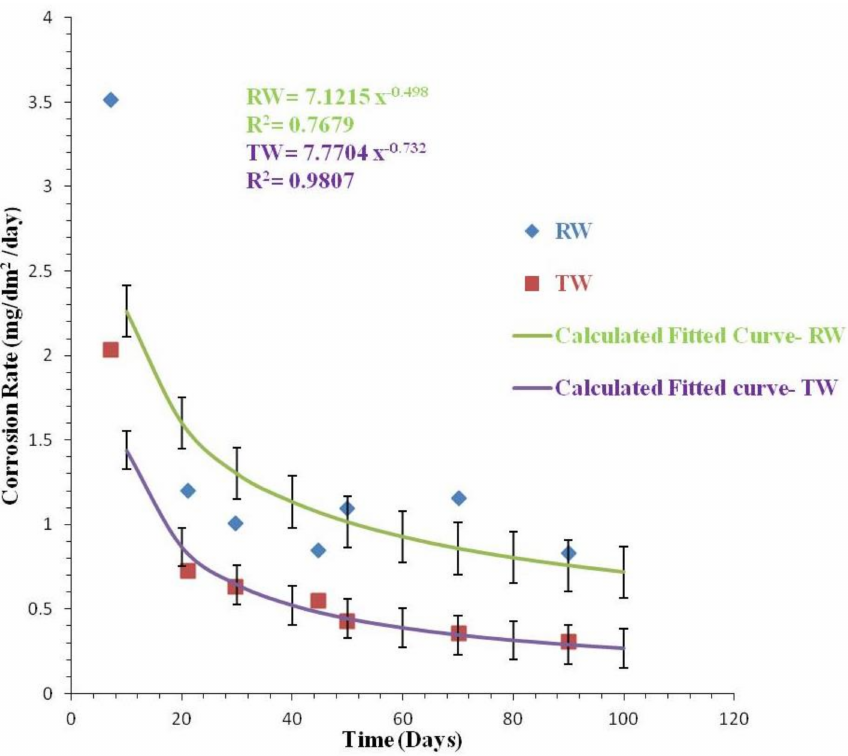
Figure 18. Corrosion rate of cast iron pipe coupons with RW and TW over time with standard error bars.